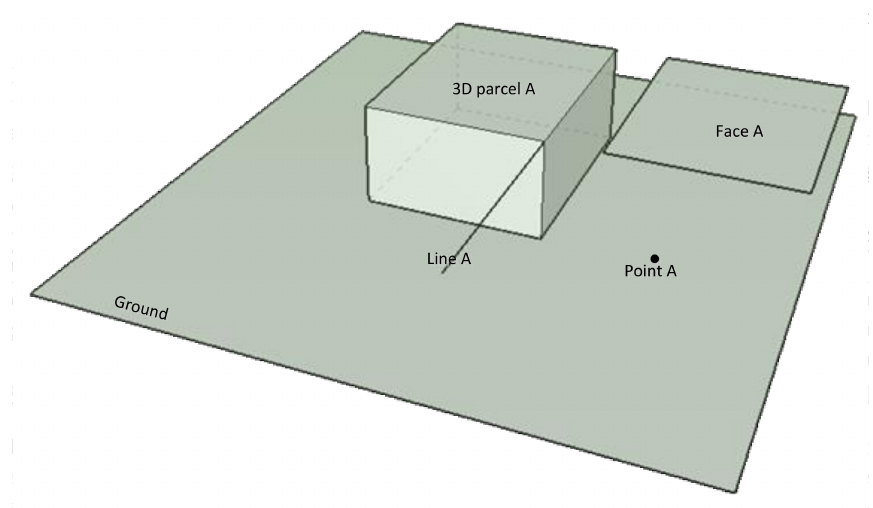
Figure 2. Examples of isolated objects in a cadastral space.